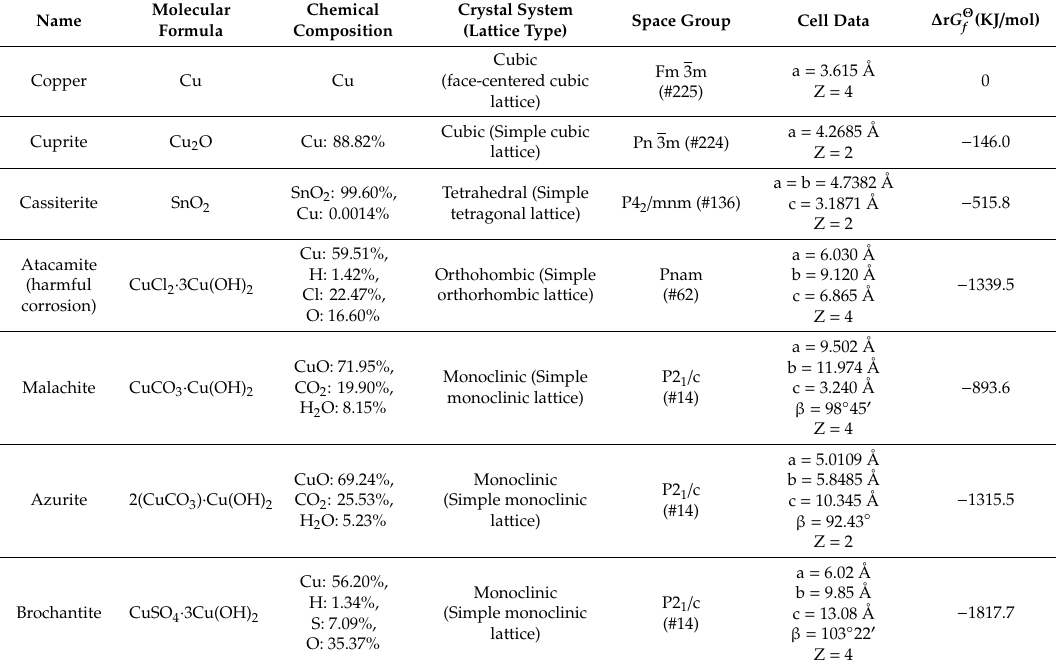
Table 3. Crystallographic and thermodynamic information of the corrosion products